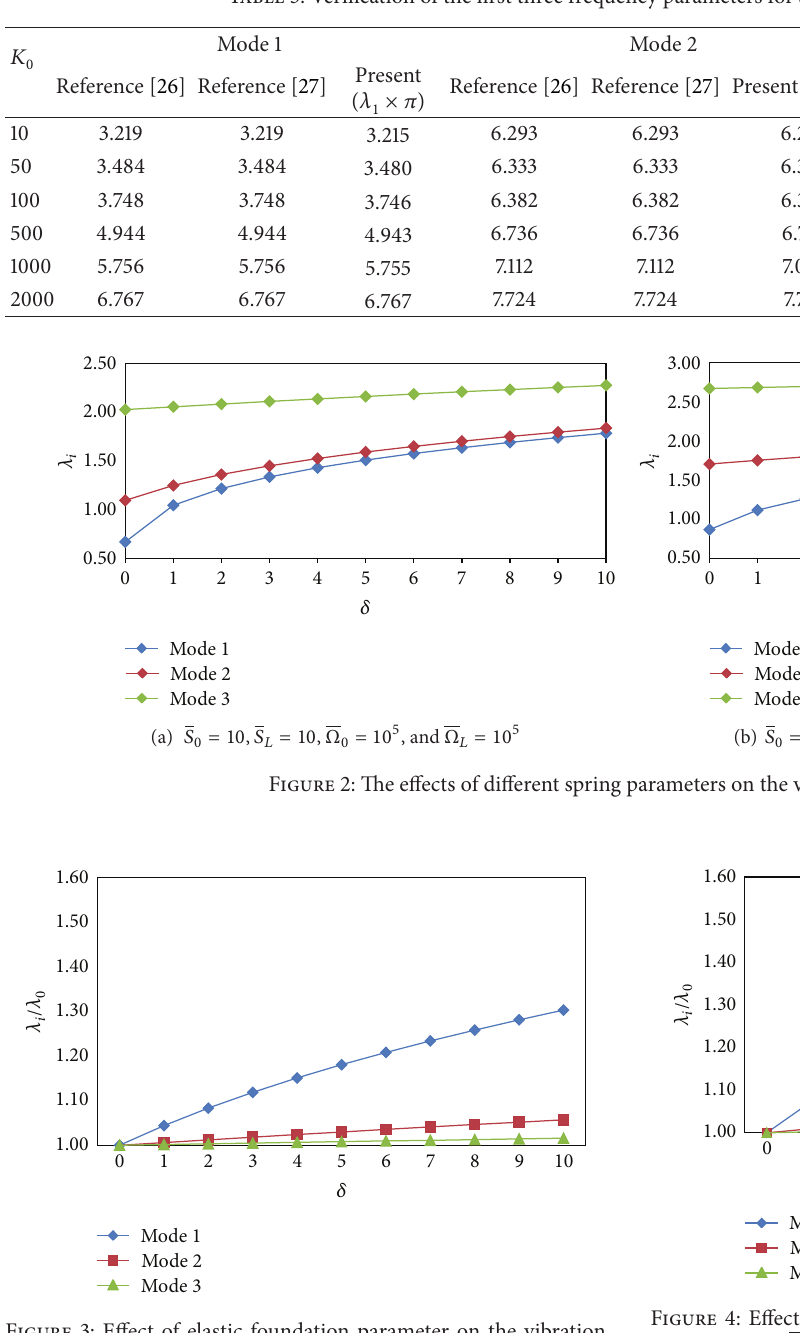
( 𝑖 ) denotes the mode number and ( 0 ) denotes the case without elastic foundation.